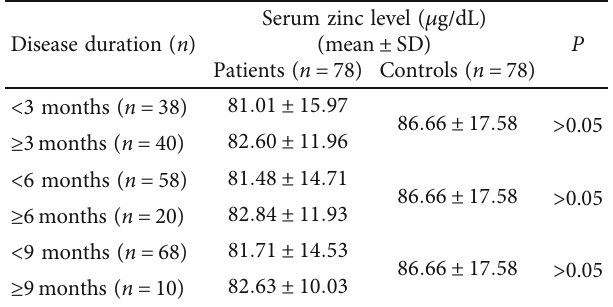
Table 2: The association between the serum zinc level and the duration of the disease (ANOVA